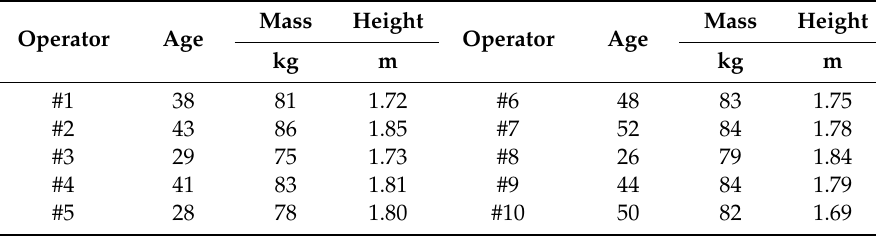
Table 1. Operators’